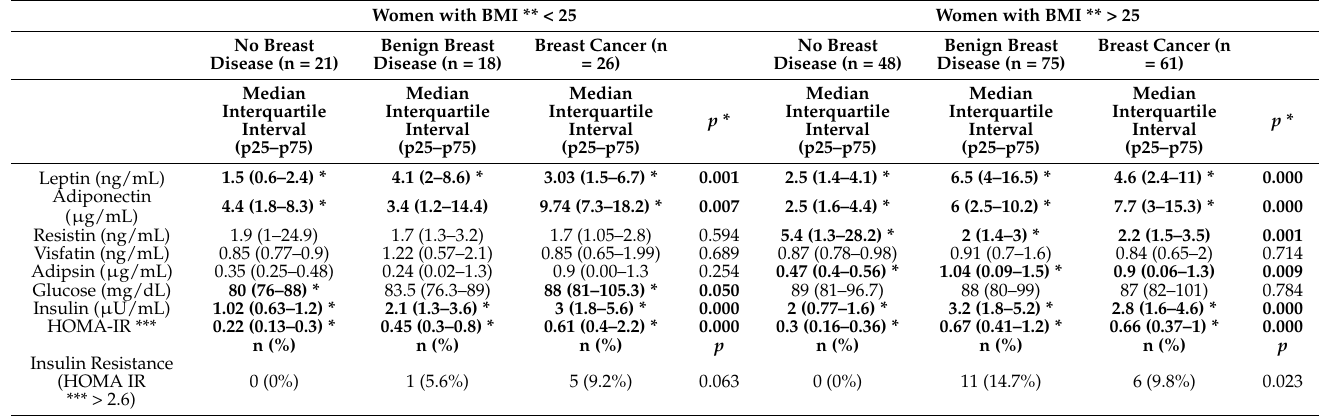
Table 3. Biochemical and metabolic indicators in a group of over-40-year-old Mexican women undergoing mastographic screening.